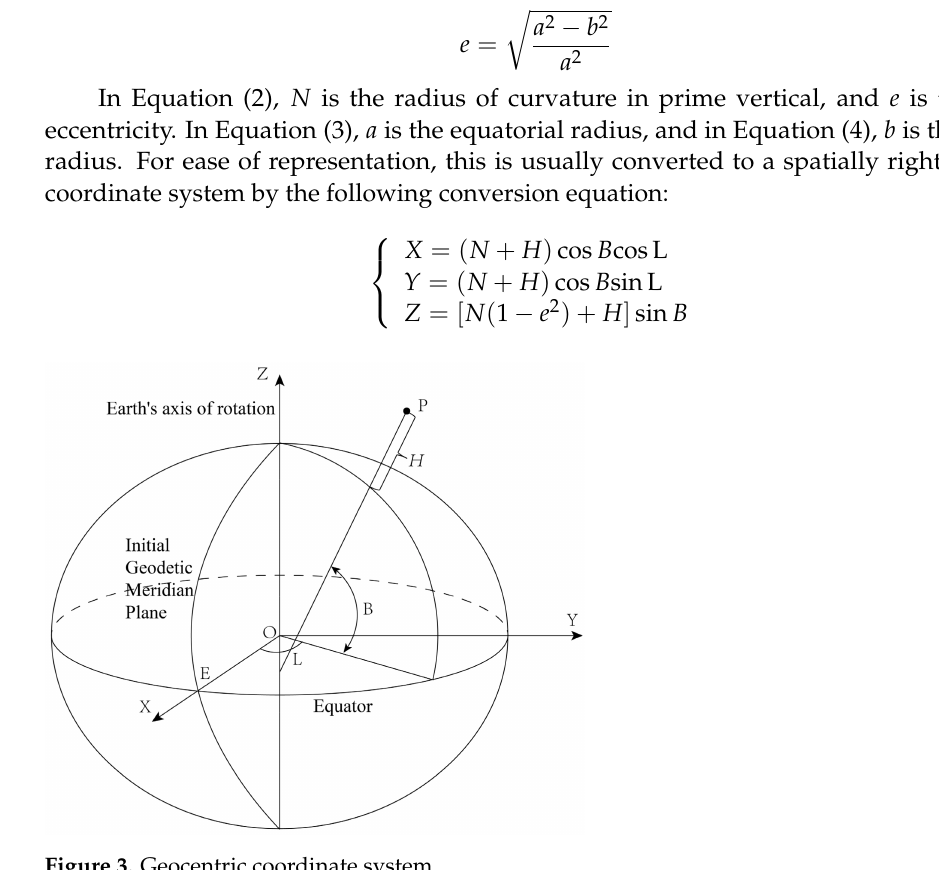
Figure 3. Geocentric coordinate